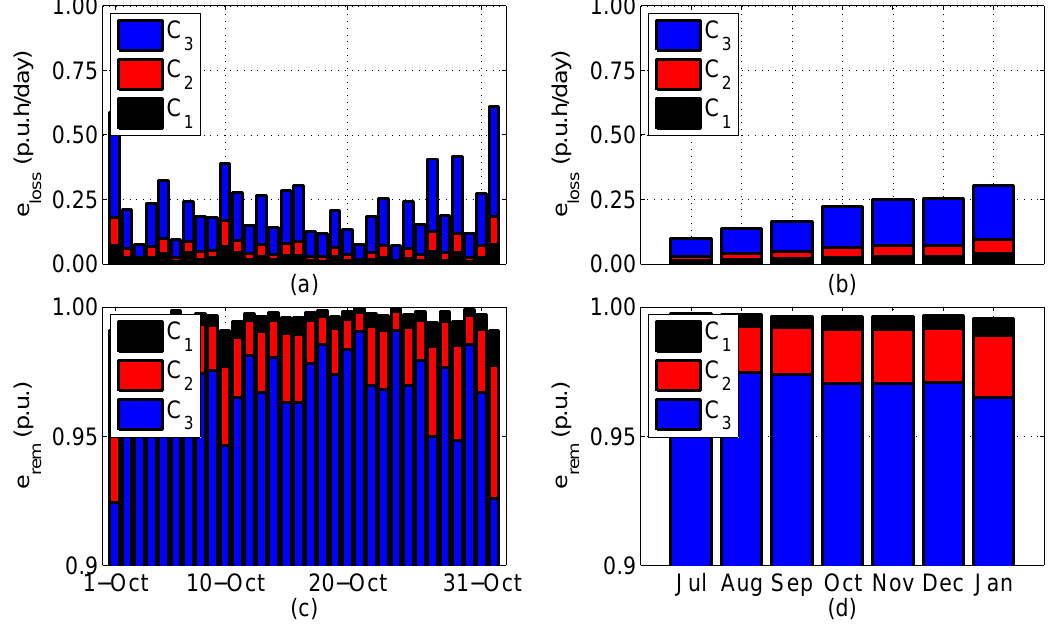
Figure 15. USPVP energy losses due to FR during a year in Chile, with f 1 at 52, 51 and 50.5 Hz, ( C 1 , C 2 and C 3 respectively): ( a ) Daily energy losses ( e loss ) in October; ( b ) monthly energy losses; ( c ) daily remnant energy ( e rem ) in October; and ( d ) monthly remnant energy.